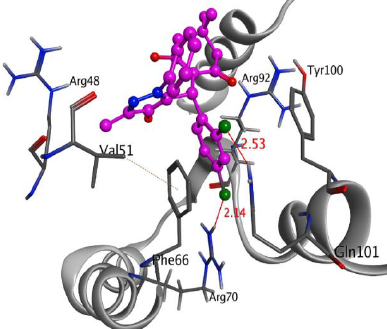
Figure 3. Docking molecular of the compound 21a (magenta) with crucial residues of thymidylate